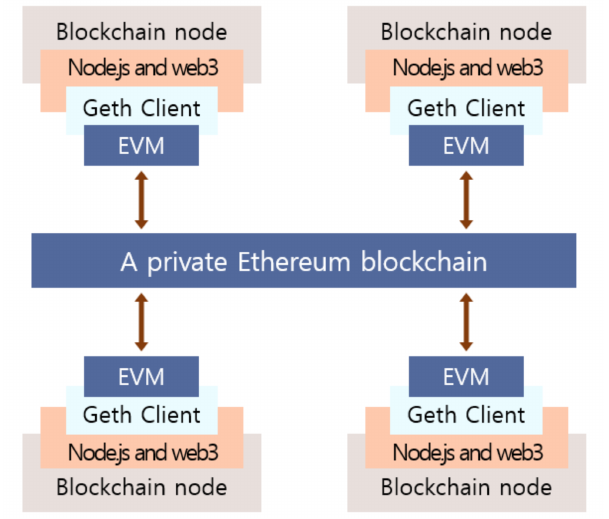
Figure 5. The software architecture of proposed peer-to-peer (P2P) energy trading implementation on a private Ethereum